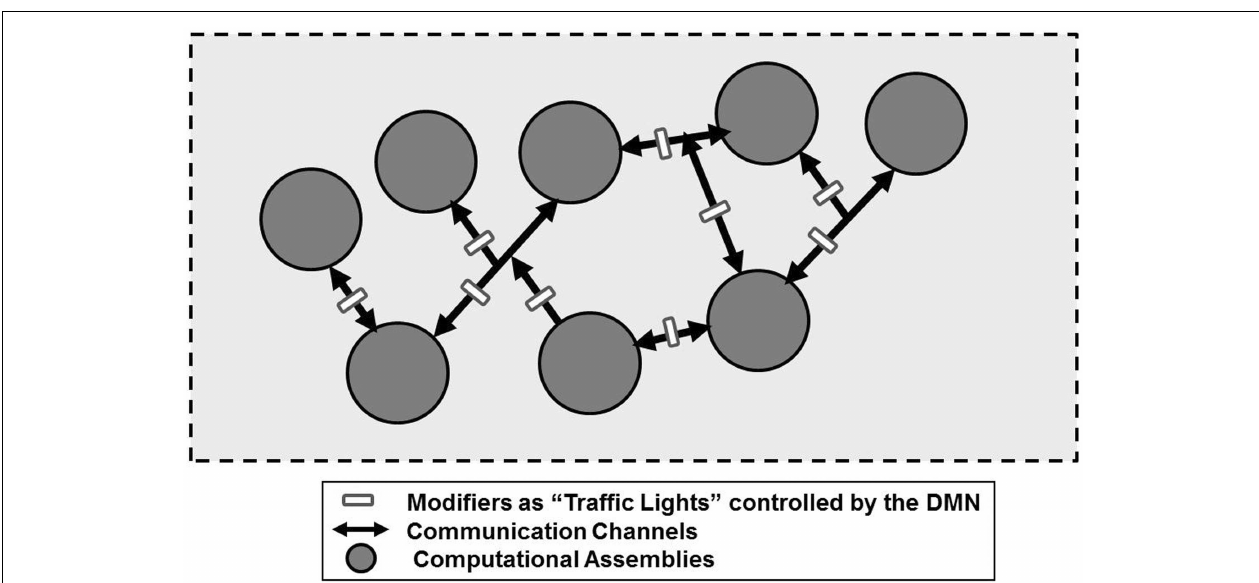
FIGURE 6 | Schematic representation of a new type of a hypothetical “machine” made by computational assemblies interconnected by pathways bearing “traffic lights” that can divert the signals along many different routes . For further details, see